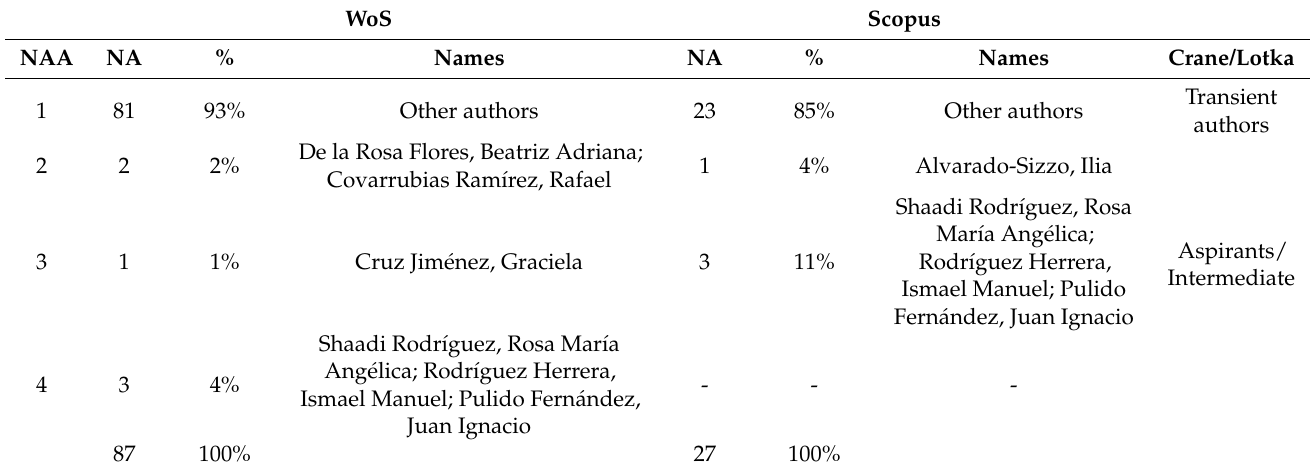
Table 5. Classification of authors using the Crane and Lotka System, WoS, Scopus.